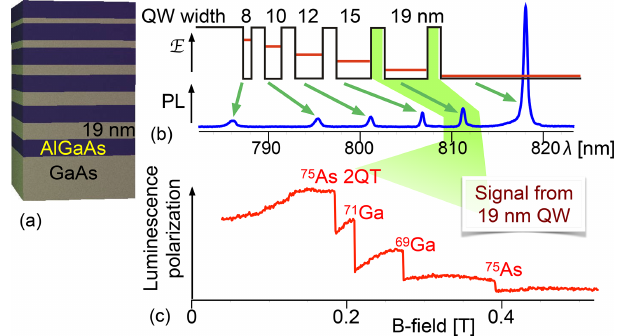
Figure 26. Optical detection of NMR in a single quantum well of a sample with five different quantum wells. (a) Structure of the sam- ple, where GaAs quantum wells of different thicknesses are sep- arated by AlGaAs barriers. (b) PL spectrum, with assignment of the individual resonance lines to specific quantum wells. Only light from the 19nm quantum well is detected. (c) NMR spectrum of the 19nm quantum well detected by scanning the magnetic field while applying an RF field with a frequency of 5MHz.